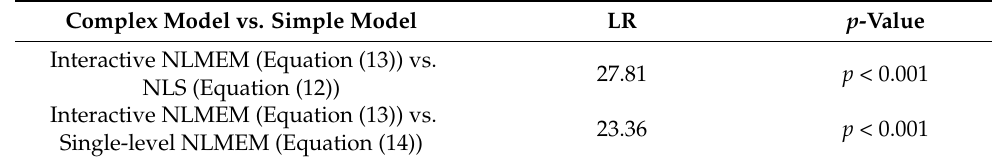
Table 9. Results of likelihood ratio test. LR is the likelihood ratio. Complex Model vs. Simple Model LR Interactive NLMEM (Equation (13))